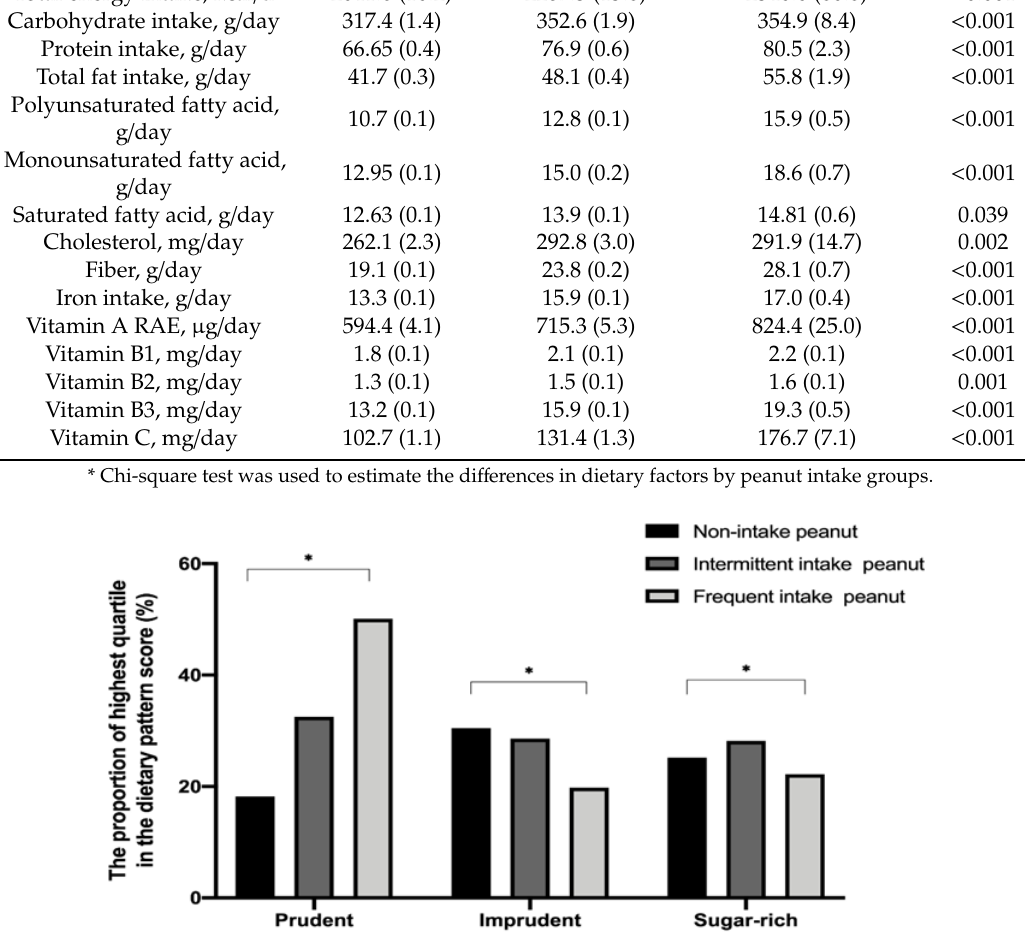
Table 3. Dietary characteristics of the study population according to the frequency of peanut consumption.